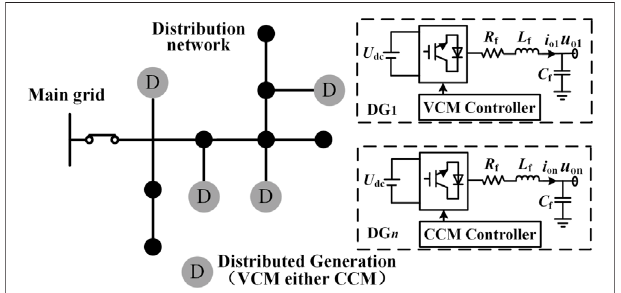
FIGURE1| Structuraldiagramofthedistribution networkwithVCMand CCM inverters.